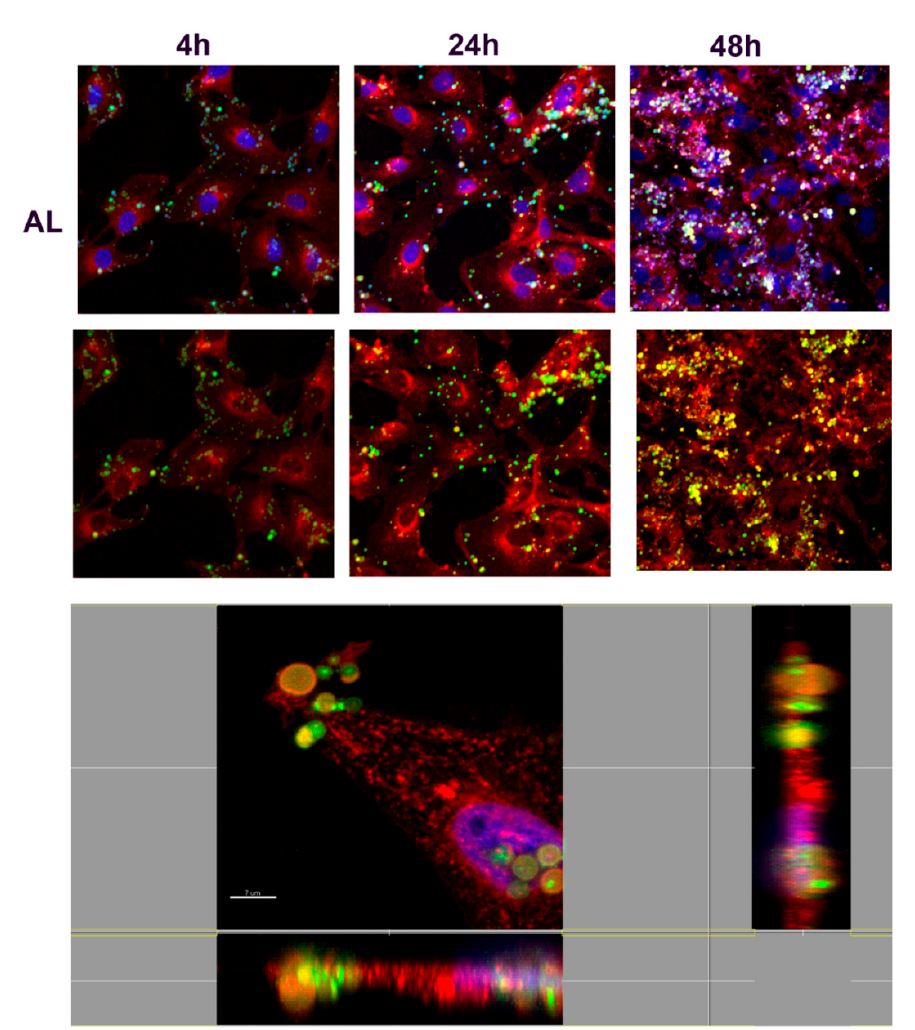
Figure 11. Confocal laser scanning microscopy images of alginate NMP cellular uptake. (TOP panel) Representative images of fibroblasts treated with FTIC-labeled alginate (AL) NMPs (green) for indicated time (4 h, 24 h, and 48 h). The cells were stained with wheat germ agglutinin conjugated to Texas Red (red) and counterstained with Hoescht 33258 to visualize the nucleus (blue). Scale bars, 30 µ m. (BOTTOM panel) Confocal X-Y, X-Z, and Y-Z sections in max intensity projection mode (MIP modality). Side panels present z -sections along the x and y planes and show the 3D distribution of cells, confirming that AL-NMPs were present in the cell surrounding after 4 h incubation. It is not clear in this case whether the NMPs are on the outside or on the inside of the cell. Scale Bar, 7 µ m.